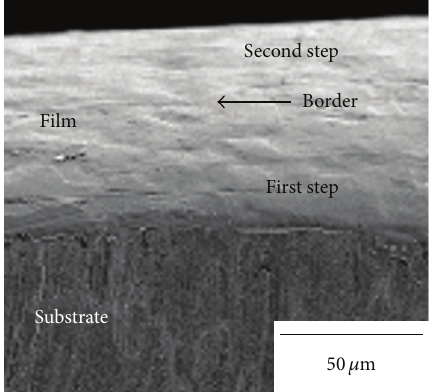
Figure 8: Cross-sectional SEM images of the films with two-step depositions. The first-step deposition condition was 0.5 wt% Y 2 O 3 concentration, with bias voltage of 0.5 V, bias frequency of 1kHz, and deposition time of 1h. The second-step deposition condition was 0.5 wt% Y 2 O 3 concentration, with bias voltage of “2.0 V,” bias frequency of 1kHz, and deposition time of